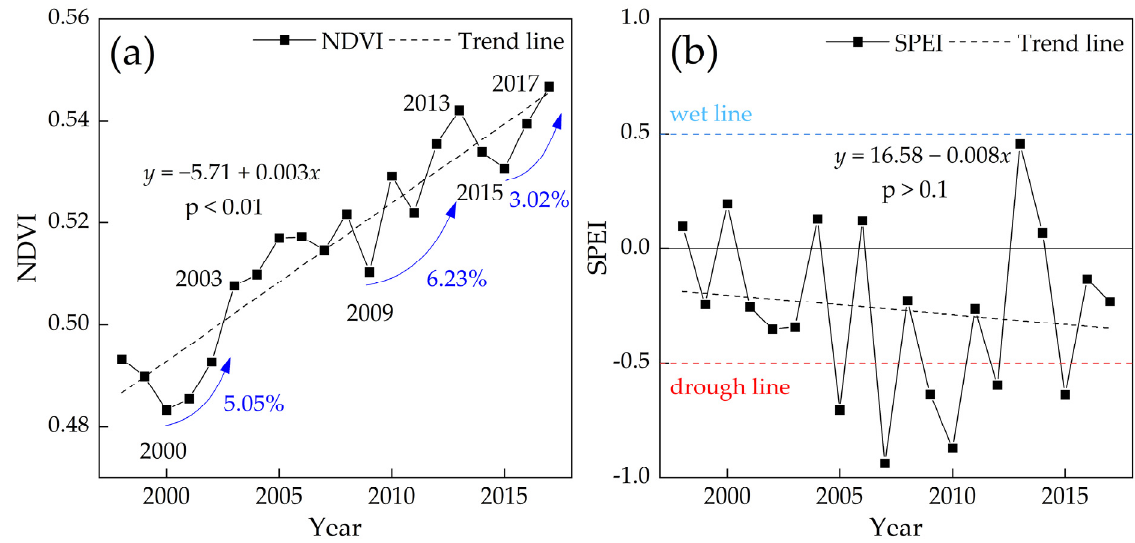
Figure 2. Variations in the ( a ) NDVI and ( b ) SPEI in China from 1997 ‒